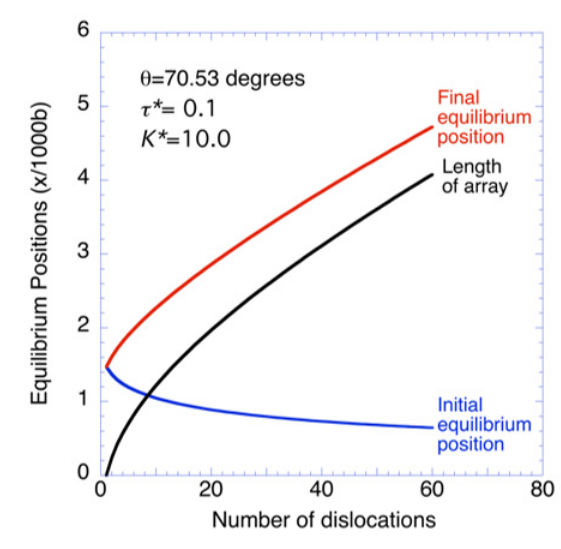
Figure 6. The diagram showing the equilibrium positions as a function of number of dislocations for = θ = 70.54 ◦ and τ ∗ i